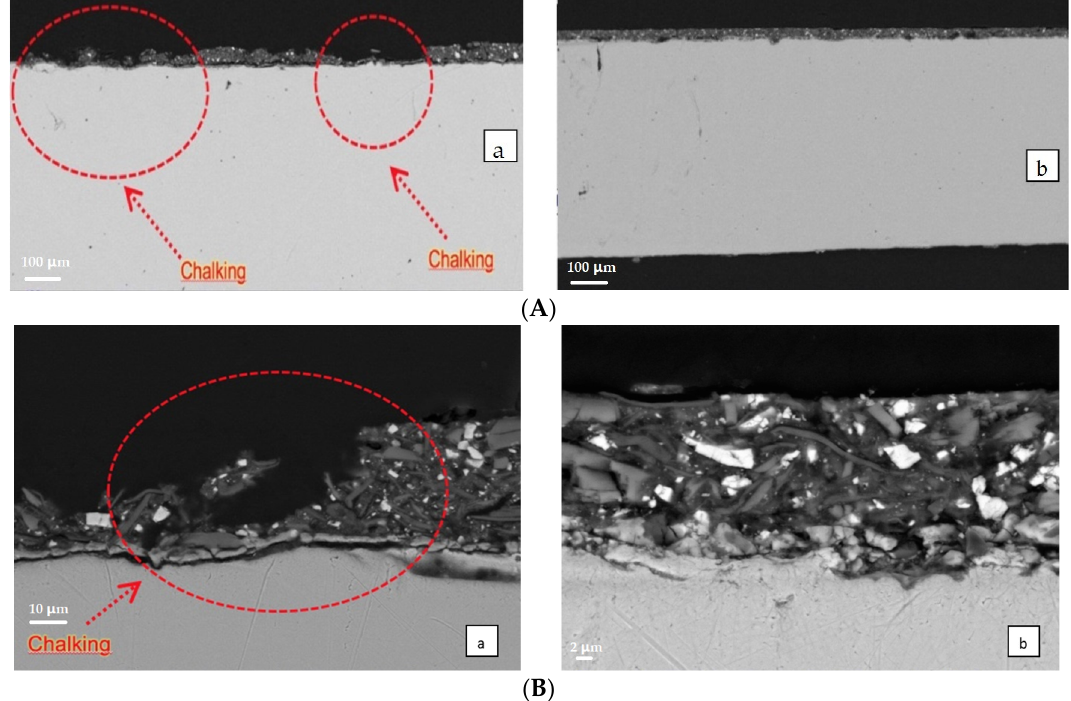
Figure 14. ( A ) Low ‐ and ( B ) high ‐ magnification images of sections after HT: ( a ) S6 coating section; ( b ) SF1 coating section.